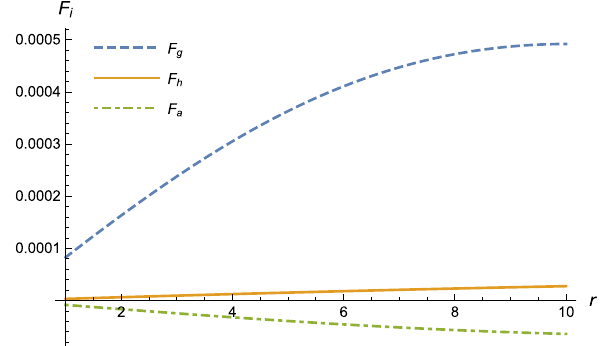
Fig. 7 The plot of gravitational force ( F g ) , hydrostatic force ( F h ) and anisotropicforce ( F a ) forthestrangestarcandidateHerX-1withrespect to the radial coordinate r